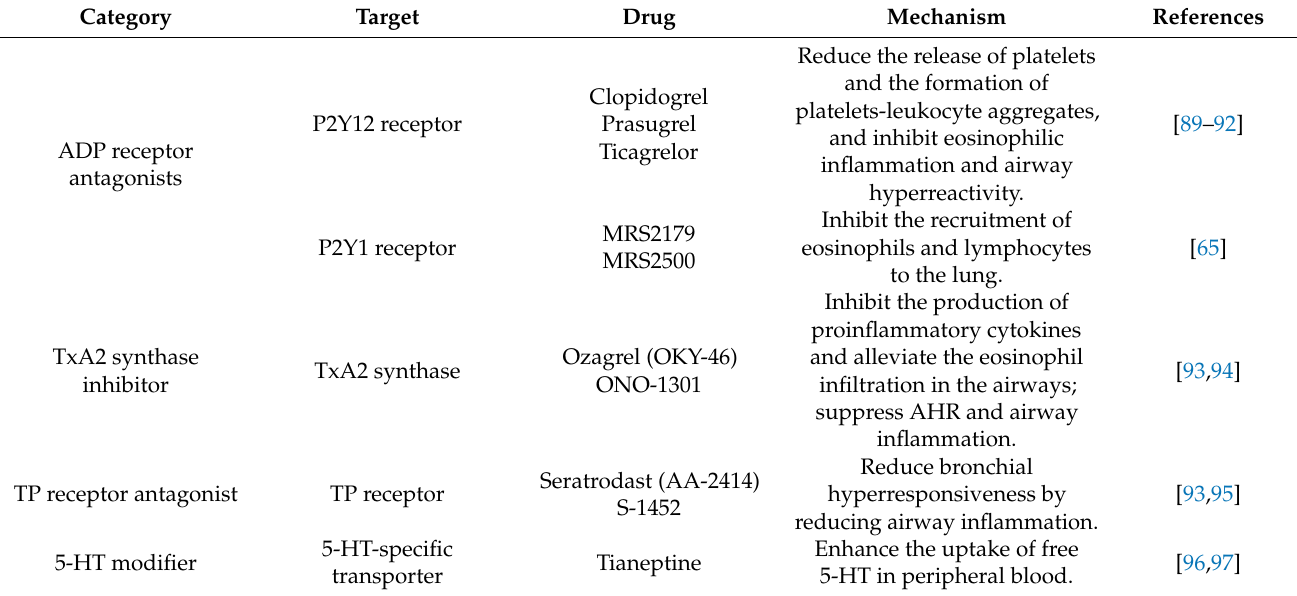
Table 3. Antiplatelet drugs for treating allergic